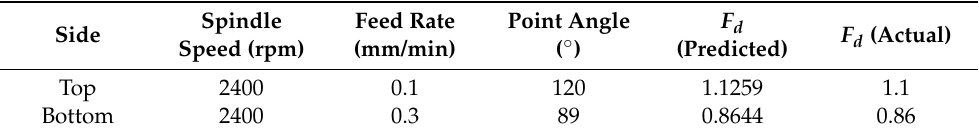
Table 3. Comparison between the predicted and actual delamination sizes at both the top and bottom sizes based on the optimal machining parameters found by